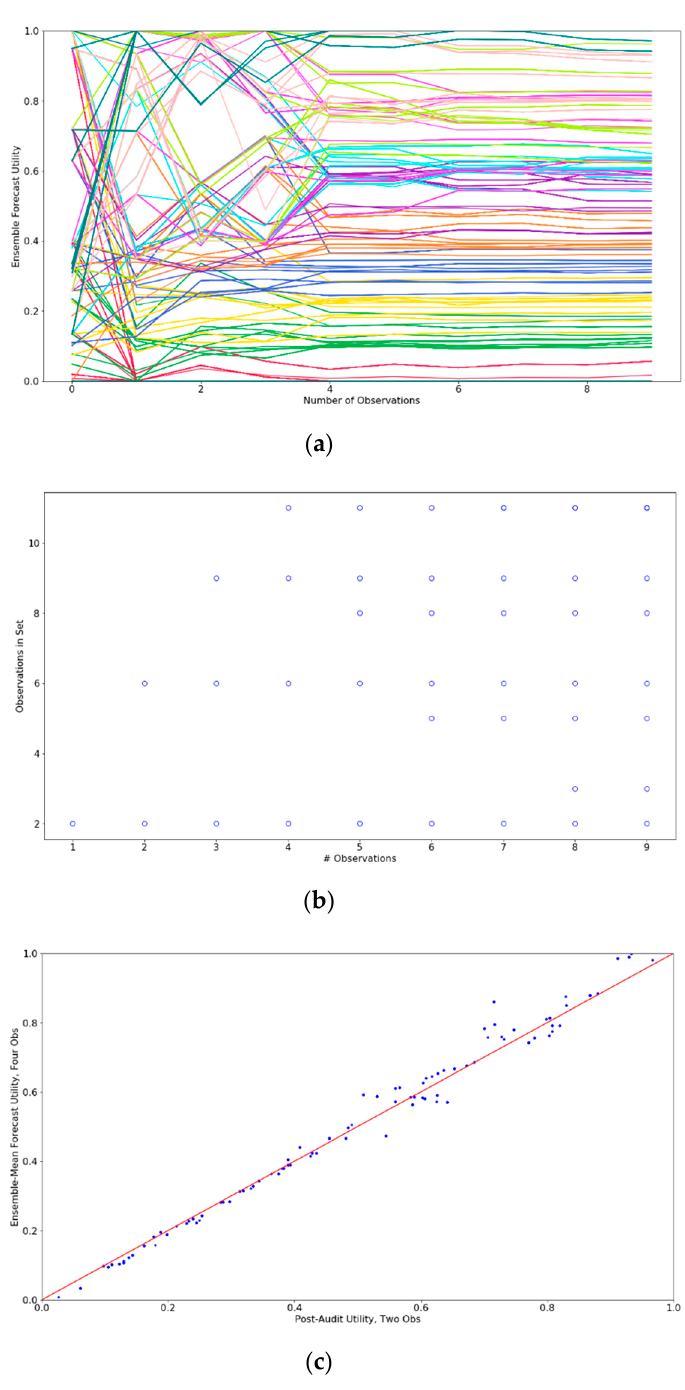
Figure 9. Evolution of ensemble forecast utility as a function of the number of observations collected. ( a ) finding the observation that minimizes the utility estimation difference from that determined using all observations for each set size. Colors group analyses by the selected utility of the truth model. ( b ) The composition of the compromise sets. ( c ) comparison of the utility estimated using two observations identified by post-audit and four observations pre-selected using the compromise optimal set approach.